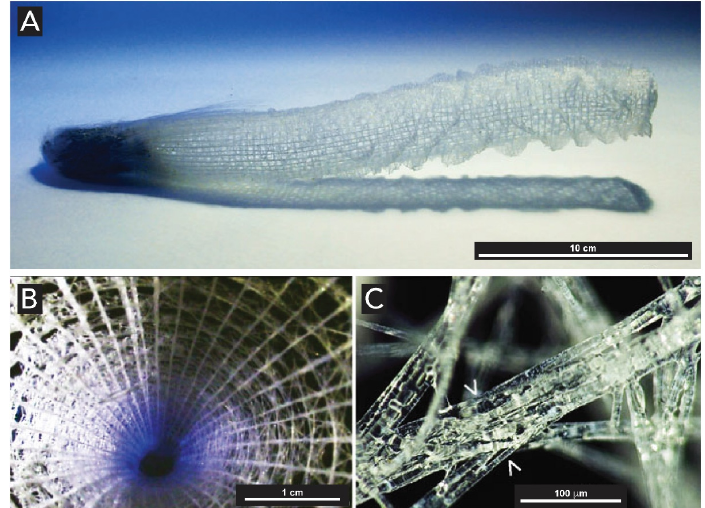
Figure 13. The skeleton of the hexactinellid E. aspergillum ( A ) is built of tightly interacting spicules ( B ). In ( C ) it is visible that those spicules even fuse together (indicated by > ). Scale bar: ( A ) 10 cm, ( B ) 1 cm) and ( C ) 100 µ m. Adapted from [100] under the Creative Commons Attribution 4.0 International